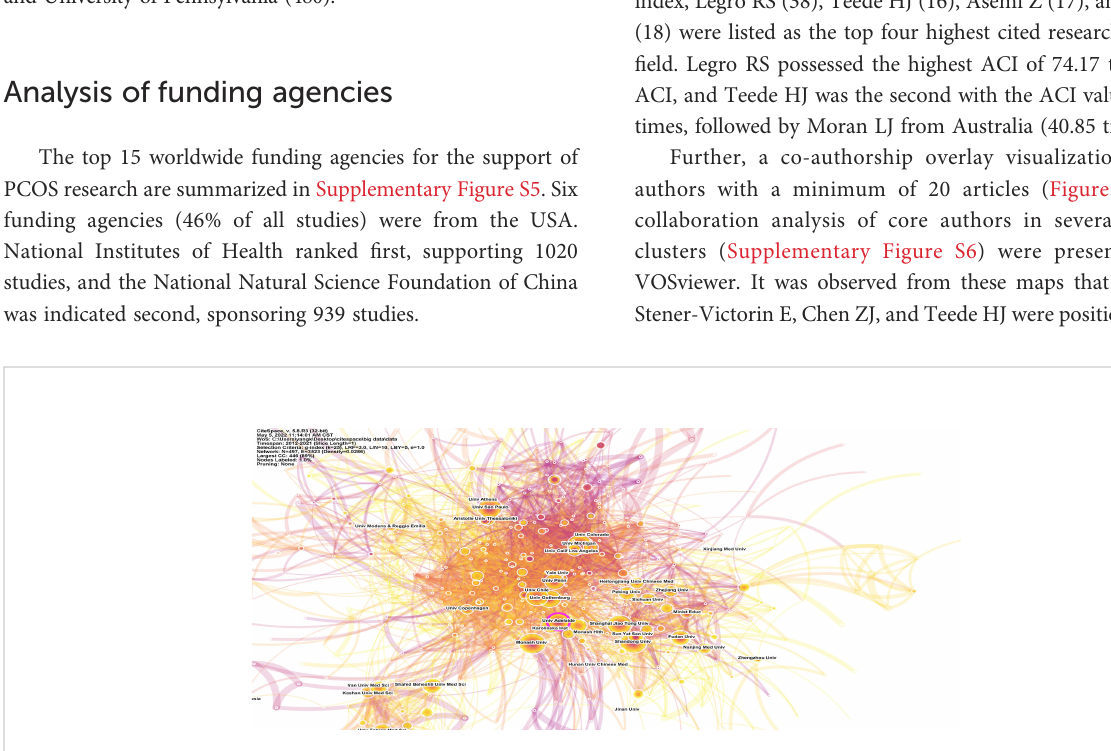
FIGURE 4 The network map of institutions by Citespace. The node size represents the number of publications from the institution. Node with purple ring in the network re fl ects it with high betweenness centrality (BC ≥